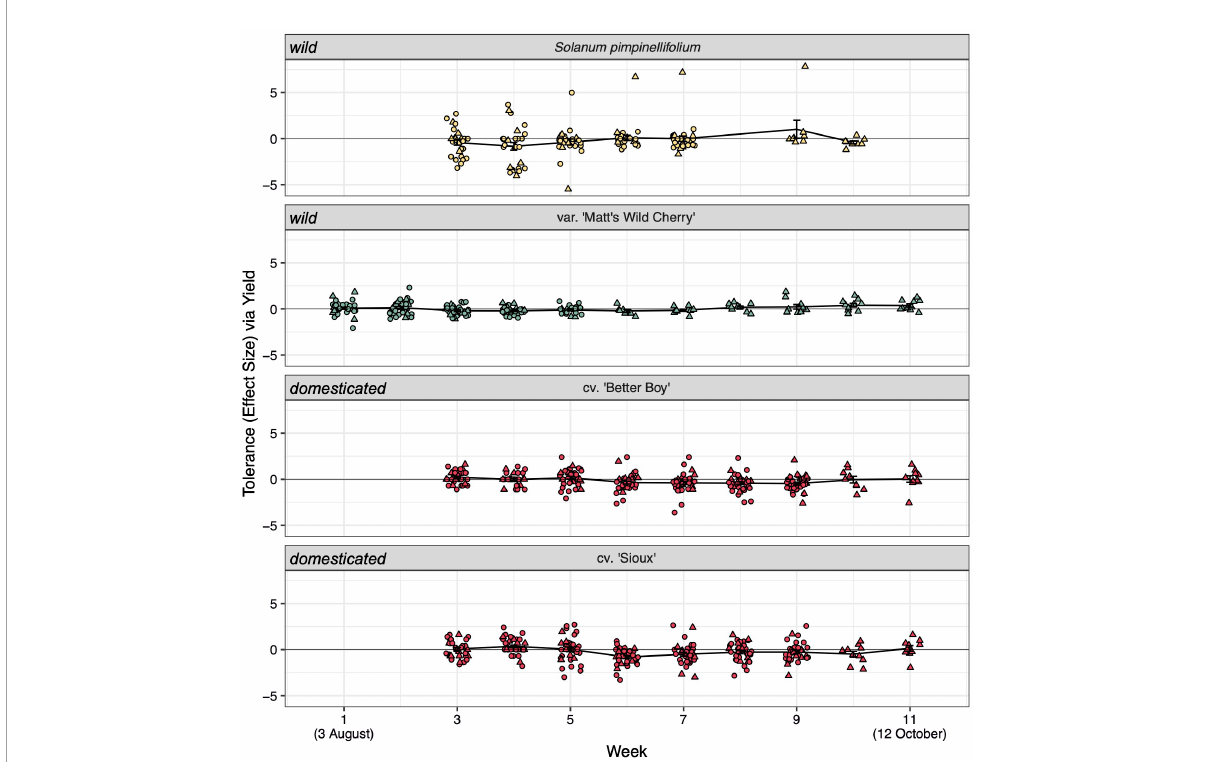
FIGURE2 Weekly estimates of tolerance to hornworm herbivory among our four tomato lines. Domestication status (wild or domesticated) is noted on the left-hand side of panels. See Supplementary Table 3 for full statistical analyses. Tolerance scores compare infested and uninfested yields within a given block and week (see formula in section “Materials and methods”). Values of 0 reflect perfect tolerance, negative values reflect low tolerance, and positive values reflect overcompensation. Tolerance estimates were calculated with the addition of a constant (= 1) to avoid undefined scores (see section “Materials and methods” for details). Point color reflects the line’s tolerance category ( Figure 1 ). Circles represent blocks that were destructively sampled before the season’s end for rhizosphere sampling (truncated lifespan) while triangles represent the n = 10 blocks allowed to naturally senesce (full lifespan).